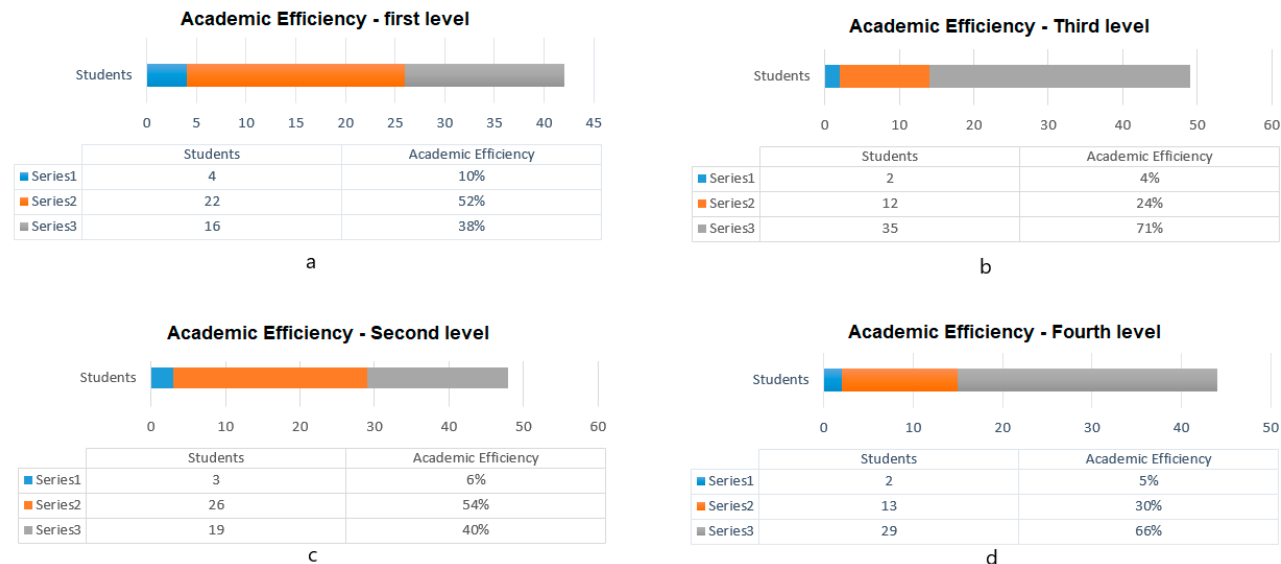
Figure 7. Analysis of the academic effectiveness (degrees) in the four initial levels of the financial career in a face-to-face education model. ( a ) first level; ( b ) third level; ( c ) second level; ( d ) forth level.